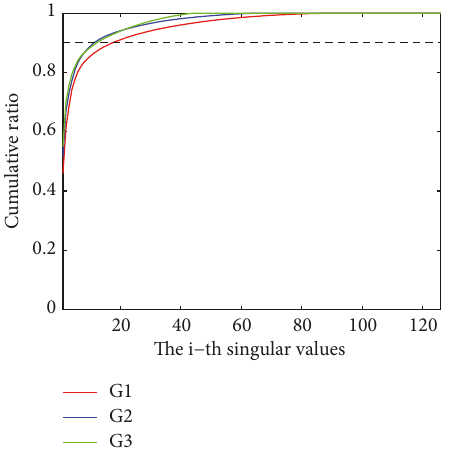
Figure 3: Cumulative ratio distribution of singular value in three ground truth datasets. Table 2: Experiment parameters.